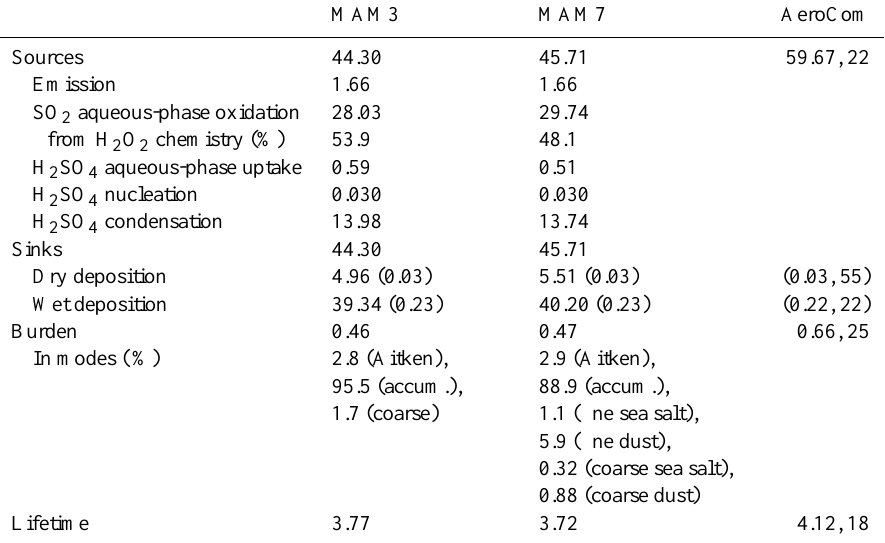
Table 3. Global annual budget for sulfate. The means and normalized standard deviations (in %) from available models participating in AeroCom (Textor et al., 2006) are listed. The values in parentheses are mean removal rates (in day − 1 ), and normalized standard deviations (in %) as budget terms are not given in Textor et al. (2006). For comparison, removal rates (in day − 1 ) from MAM3 and MAM7 are listed in